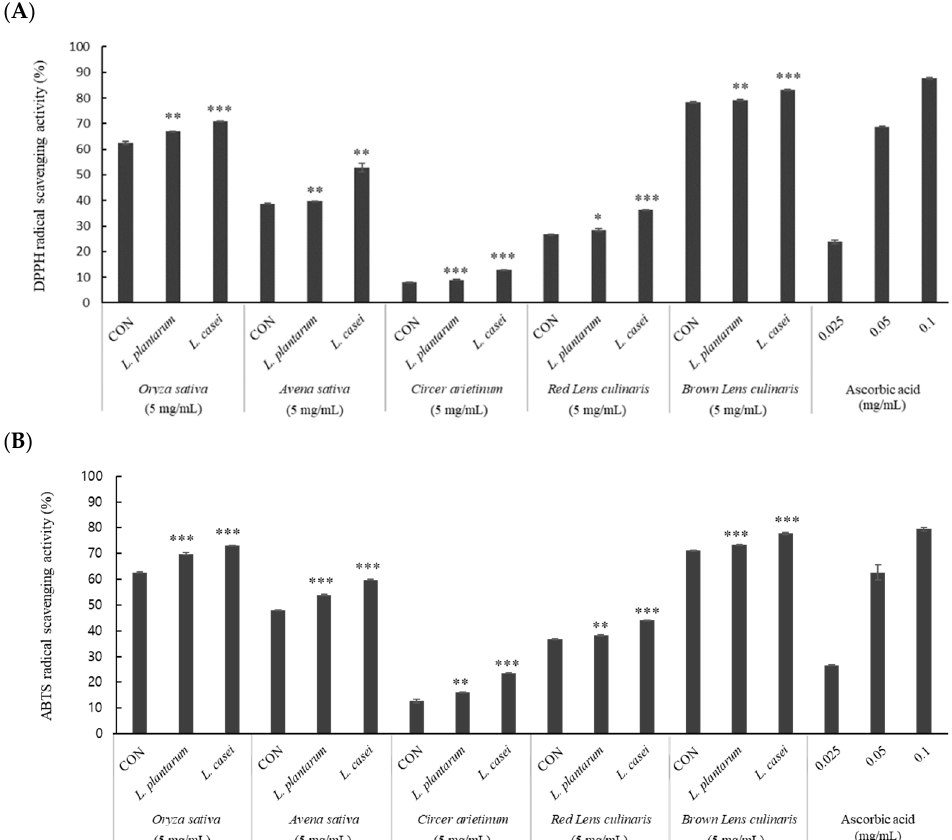
Figure 7. DPPH ( A ) and ABTS ( B ) radical scavenging activity of Oryza sativa , Avena sativa , Circer arietinum , red Lens culinaris , and brown Lens culinaris extracts. CON: Control; The results were shown as the mean ± SD of three independent experiments ( n = 3). * p < 0.05, ** p < 0.01, and *** p < 0.001, significantly different from control (Student’s t -test).